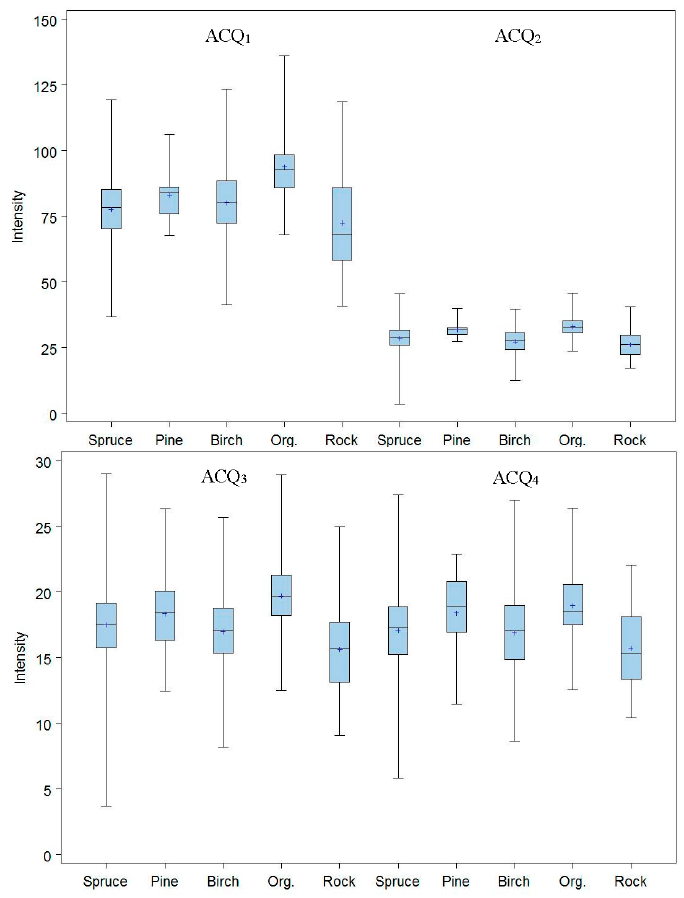
Figure 6. Boxplot of range-normalized intensity values of all echoes with h > 0 distributed on object type and ALS acquisition (Org.: Tussocks, hummocks, and rocks covered with moss and other vegetation).